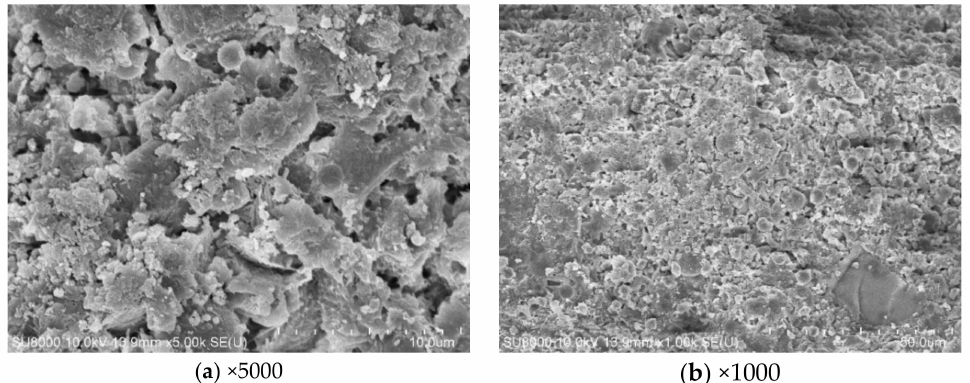
Figure 13. SEM images of sample containing BF2. ( a ) × 5000. ( b ) ×